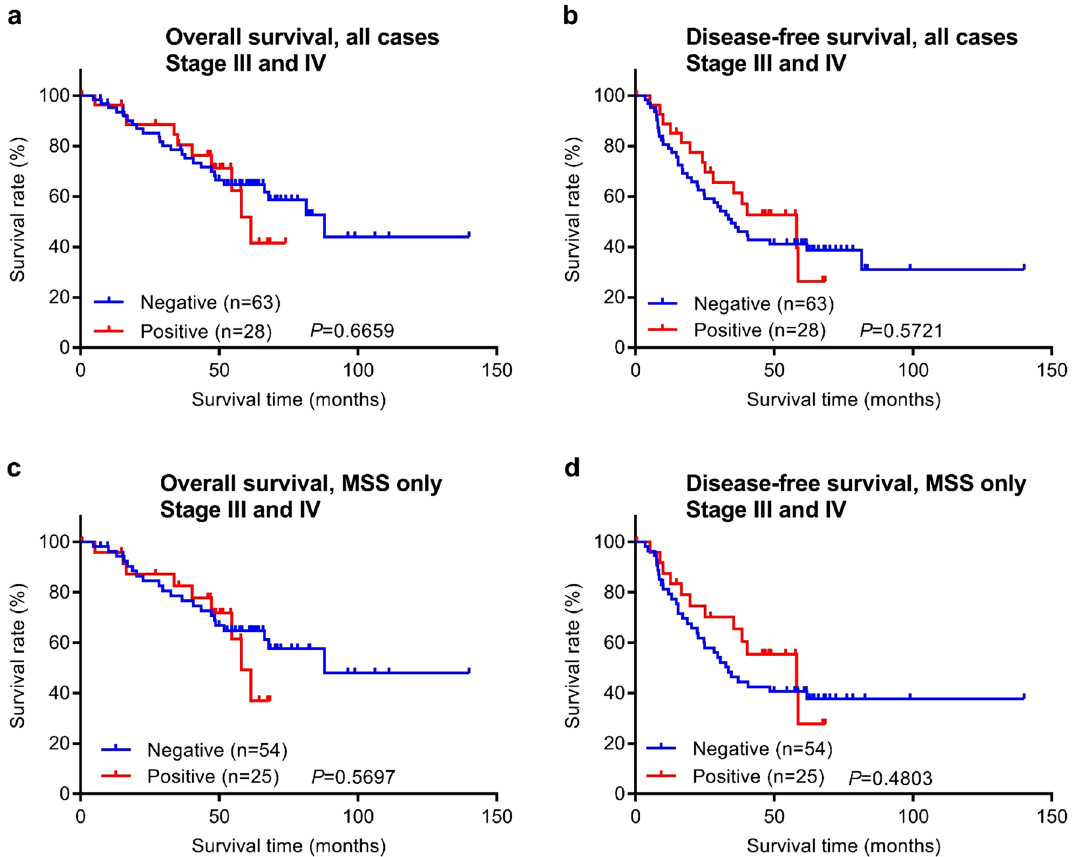
Figure 5. Overall survival and disease-free survival analysis of late stage (stages III and IV) CRC stratified by DDX21 protein expression. ( a , b ) Kaplan–Meier curves with stratification by DDX21 protein expression for all cases (n = 91). ( c , d ) Kaplan–Meier curves for MSS CRC cases only (n = 79). Note that Kaplan–Meier statistics for MSI CRC cases only were not meaningful and are thus not shown due to the small number of cases in that group (n = 12).